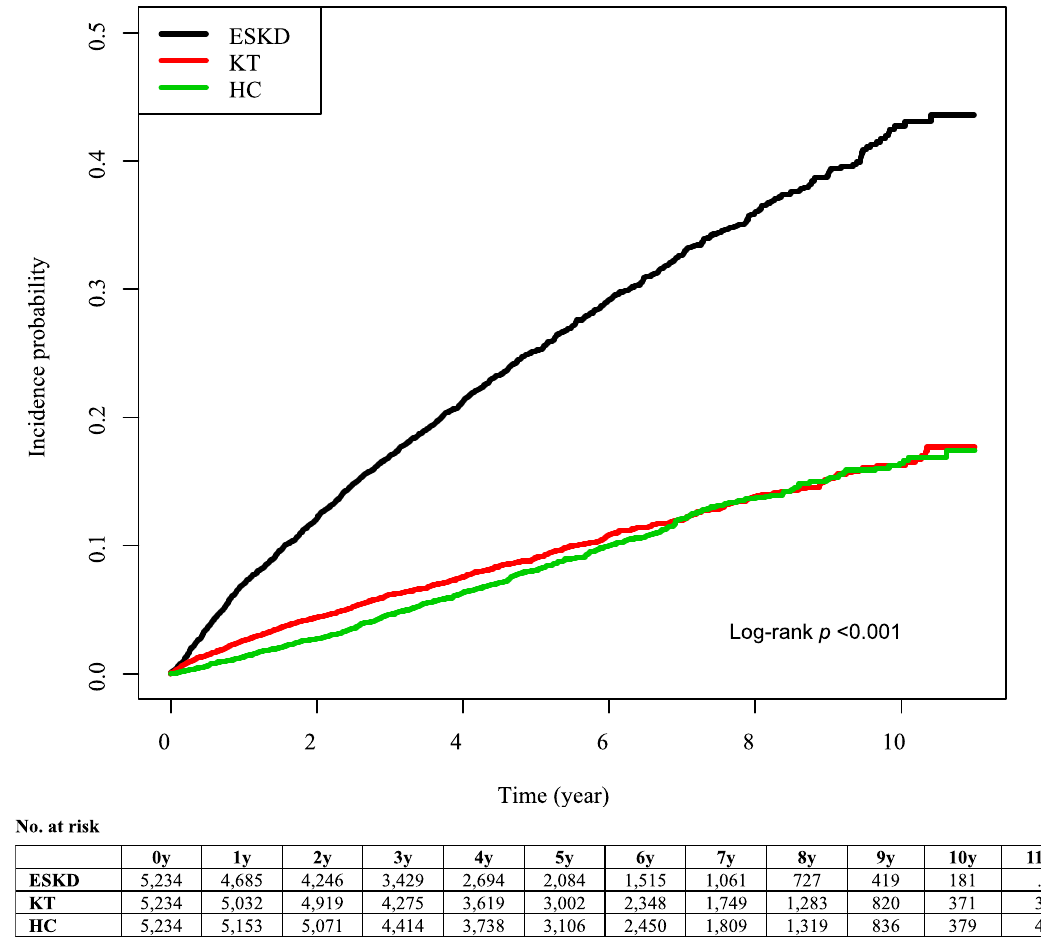
Figure 3. Cumulative risk for incident depression in KT, ESKD and HC group. Abbreviation: ESKD, end-stage kidney disease; KT, kidney transplant; HC, healthy